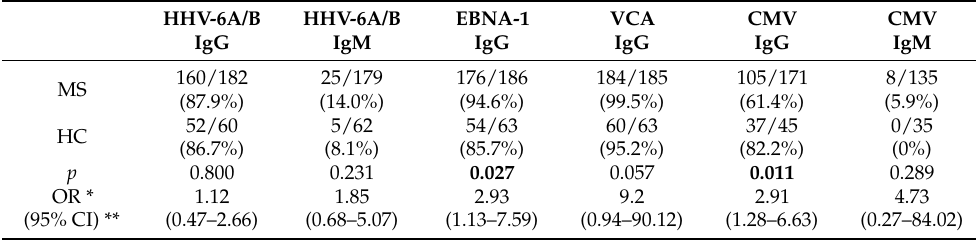
Table 2. IgG and IgM prevalence of the viruses included in the